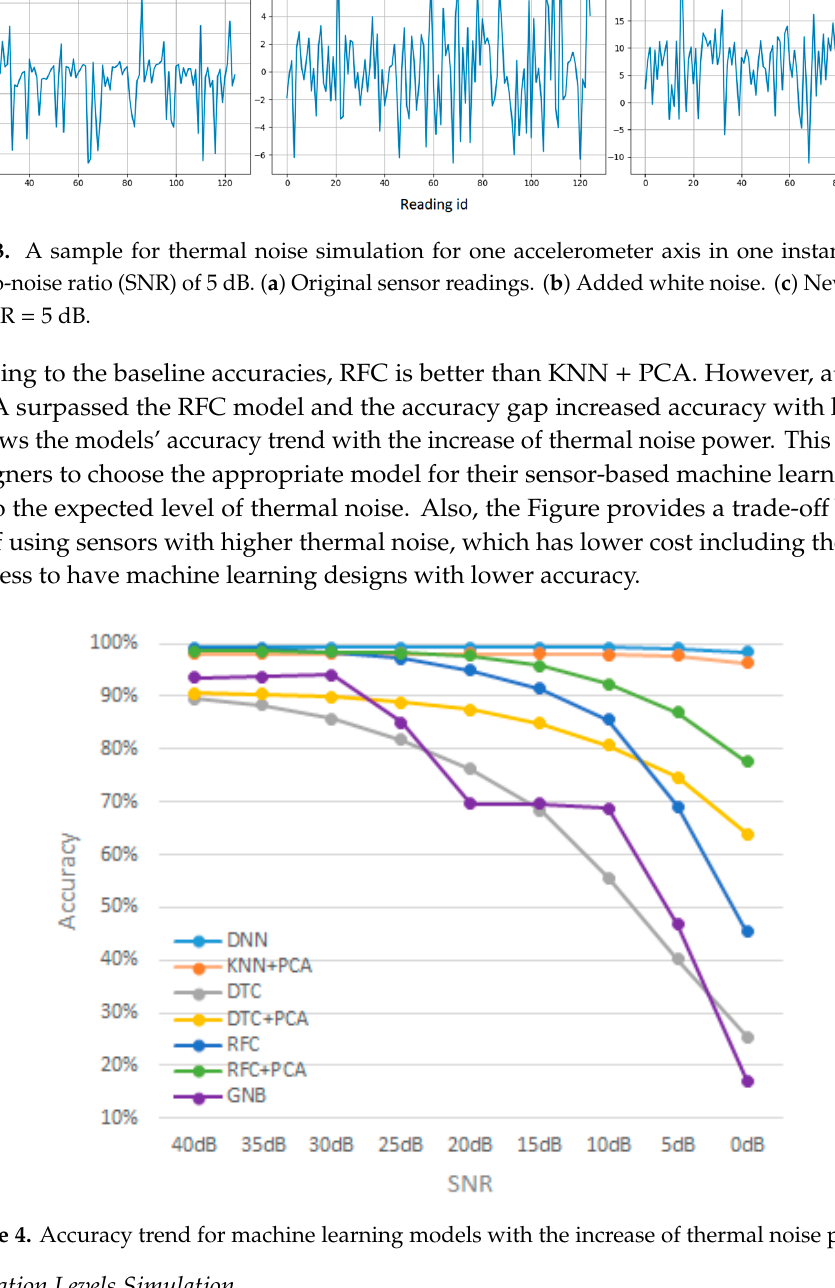
Figure 2. A histogram for a thermal noise sample added to one accelerometer axis in all test instances.